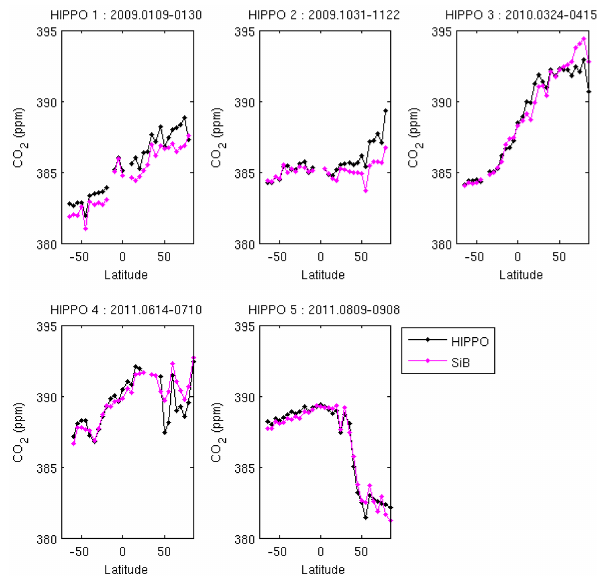
Figure 7. Comparison of HIPPO CO 2 measurements (black) and model simulations with SiB land fluxes